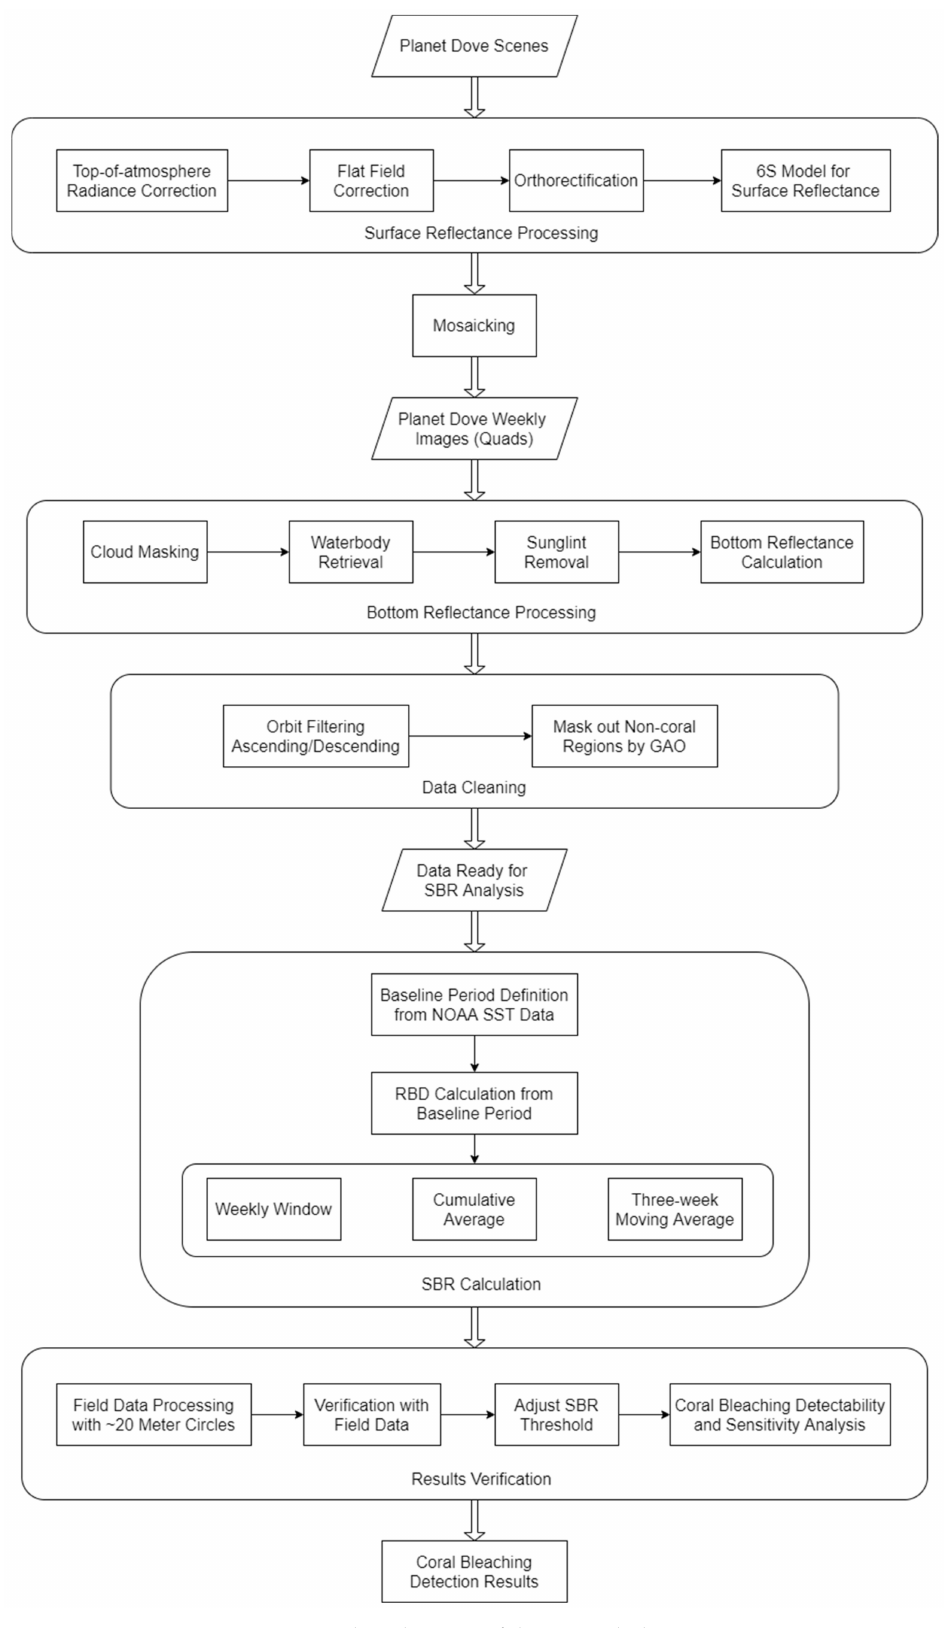
Figure 2. Flow diagram of the research